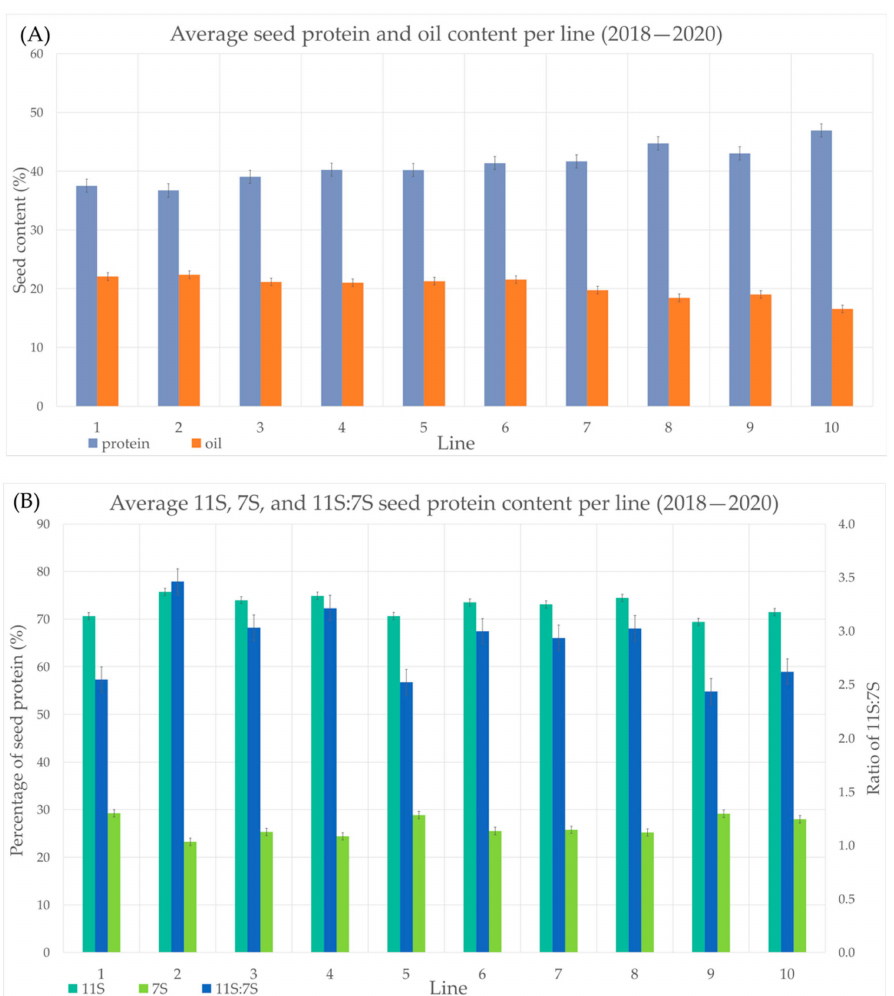
Figure 1. Seed composition across each variety from 2018–2020. ( A ) Average TP and seed oil content as a percentage of the seed weight. ( B ) Average 11S and 7S protein content as a percentage of total seed protein (primary y axis) and the average 11S:7S ratio (secondary y axis). Error bars indicate the least squares difference per